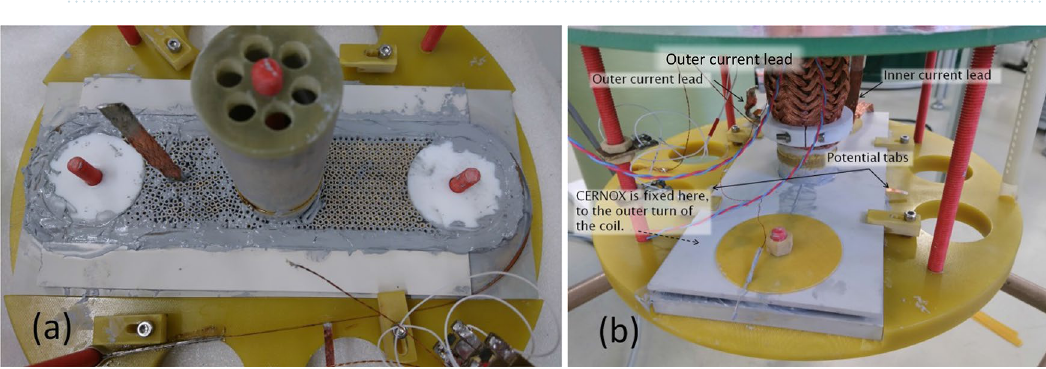
Figure 2. ( a ) The coil filled by ceramic beads and covered by thermal conductive grease. ( b ) The finished measuring setup prior inserting into the